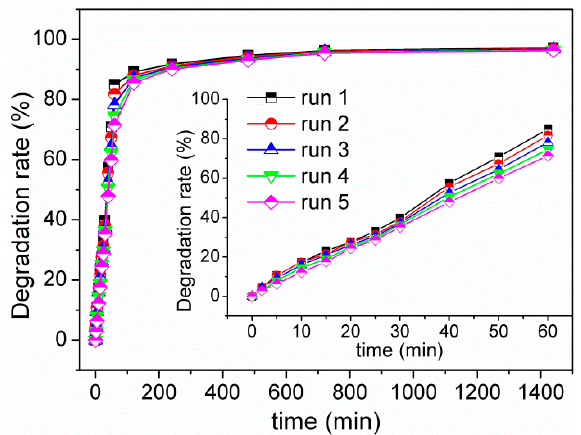
Figure 8. Photocatalytic degradation rates for multiple cycles for AO7 dye by 2 / H 2 O 2 under daylight. Inset: Highlight the photocatalytic degradation rates within 60 min.